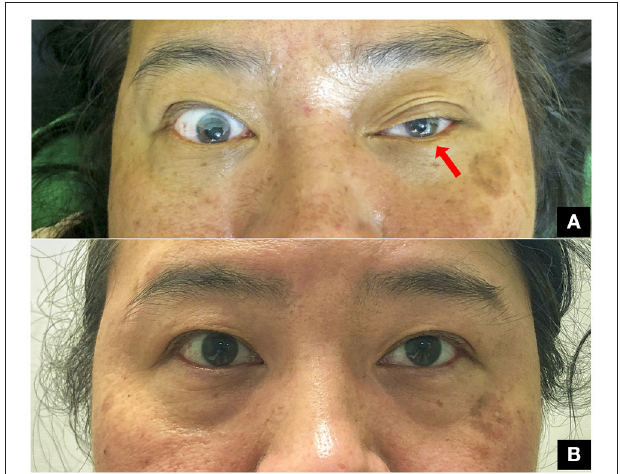
FIGURE 2 | Gross appearance of the patient. (A) Ptosis and myosis on the left side observed in the emergency department (room light). (B) Symmetrical eye opening and pupil size at outpatient clinic on the third month (room